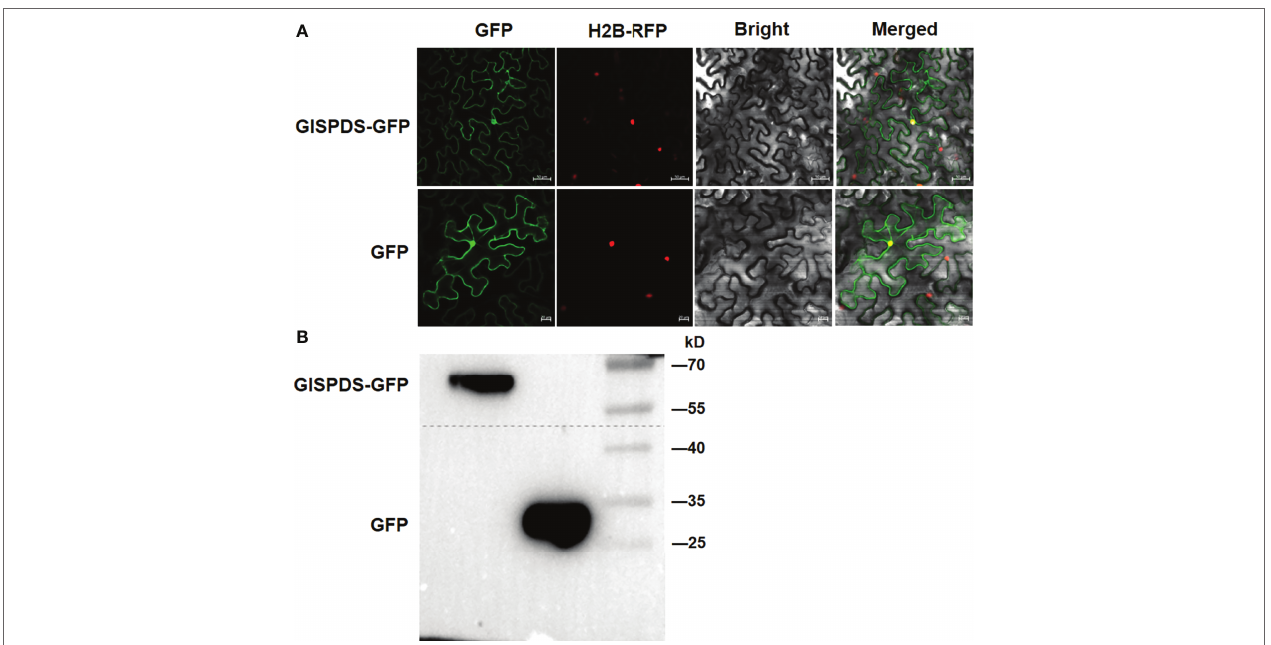
FIGURE 3 | Subcellular localization and western blotting detection of GlSPDS protein. (A) Subcellular localization of GlSPDS protein. Agrobacteria carrying pCambia 2300-GFP-GlSPDS or pCambia 2300-GFP were infiltrated into leaves of N. benthamiana expressing a red nucleus marker RFP-tagged histone H2B (H2B-RFP) and the images were taken at 48 h after infiltration under dark field for green fluorescence (left) and red fluorescence (middle right), white field for cell morphology (middle left) and in combination (right), respectively. (B) Western blotting detection of GlSPDS-GFP fusion protein. Total proteins were resolved by SDS-PAGE and probed with anti-GFP